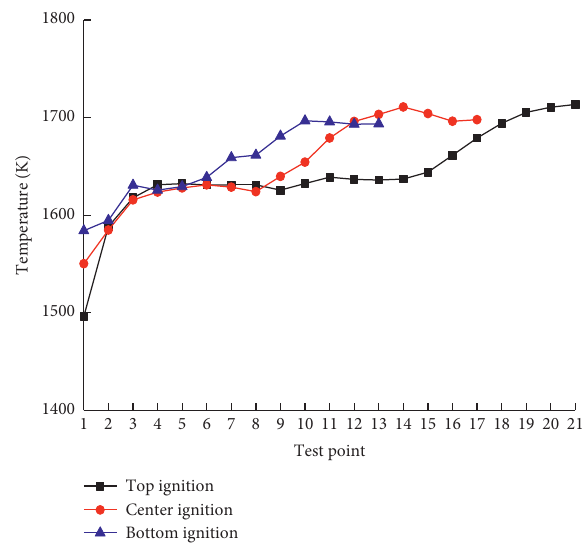
Figure 6: Curves of peak temperature under different ignition